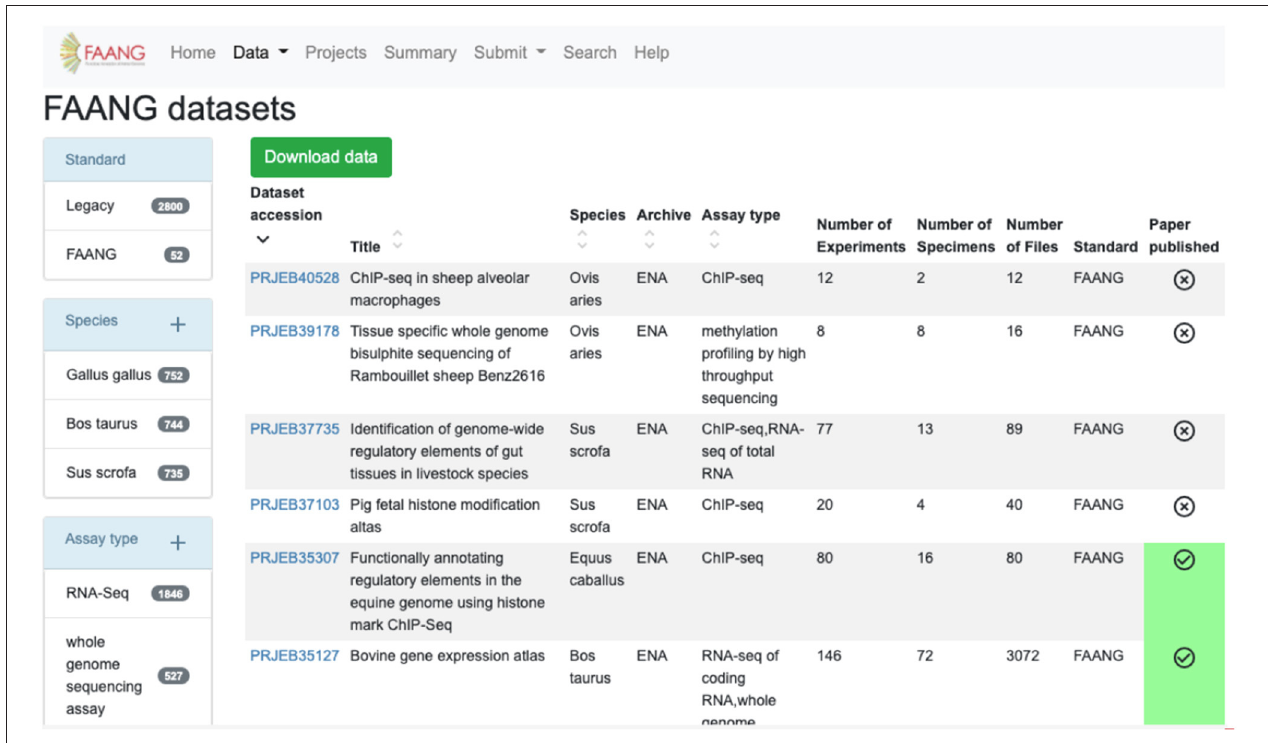
FIGURE 2 | FAANG Data Portal presenting rich ‘omic datasets to the community complete with preconfigured data filters, automated literature scraping, and direct links to data files in underlying archives (https://data.faang.org/dataset).